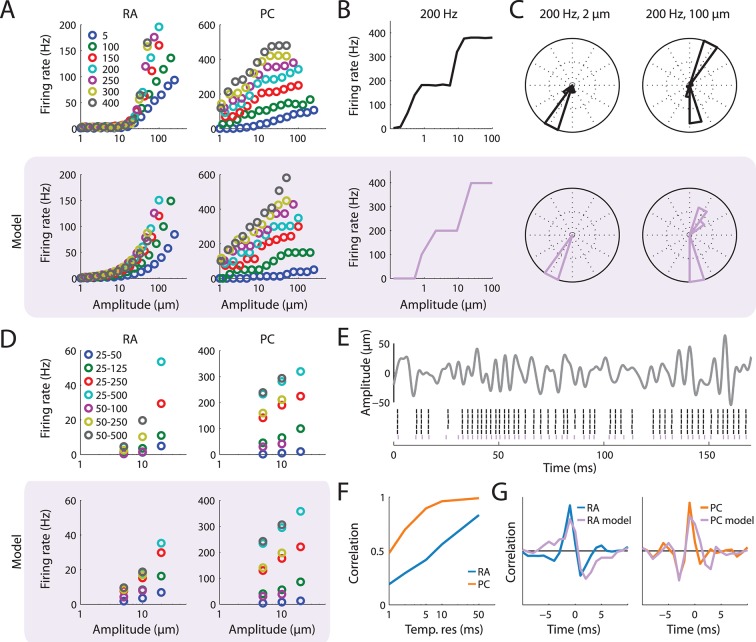
Simulation of populations of RA and PC afferents.(A) Recorded (top) and simulated (bottom) responses of RA and PC populations to sinusoidal skin vibrations of different amplitude and frequency. The model predictions closely approximate measured firing rates. (B) Rate-intensity function for a recorded (top) and simulated (bottom) PC afferent stimulated with 200 Hz sinusoidal vibrations. Both the recorded and modeled PC afferent exhibit entrainment plateaus. (C) Cycle histograms for a recorded (top) and a simulated (bottom) PC afferent. At low amplitudes, a single spike is elicited per cycle, which is precisely timed to occur at the same phase within the cycle (left column). At higher amplitudes, more than one spike per cycle can occur in complex but repeatable patterns (right column) (Whitsel et al., 2000). Both of these effects are captured by the model. (D) Mean rate-intensity functions for recorded (top) and simulated (bottom) populations of RA and PC fibers stimulated with bandpass noise skin vibrations of different amplitudes and frequency composition (legend denotes frequency ranges in Hz). The model predictions closely approximate recorded firing rates. (E) Reproducing precise spike timing for bandpass noise stimuli. Top: Example of a noise trace. Bottom: Recorded (black) and simulated (lavender) response a single PC fiber to stimulus. The simulated spike train matches the recorded ones with high temporal precision. (F) Correlation between recorded and simulated RA (blue) and PC (orange) population response for noise stimuli at different temporal resolutions. The lower correlation for the RA responses at the finest temporal resolution reflects the fact that RA responses are not very repeatable at those timescales (Mackevicius et al., 2012). (G) Mean spike triggered averages (STA) for RA (left) and PC (right) fibers calculated from both the recorded (blue and orange) and modeled (lavender) data with respect to the stimulus trace. The STA for the model and the recorded peripheral data agree well.